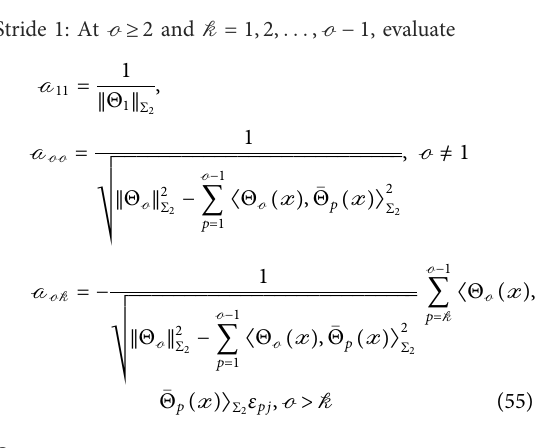
Algorithm 1. Problem